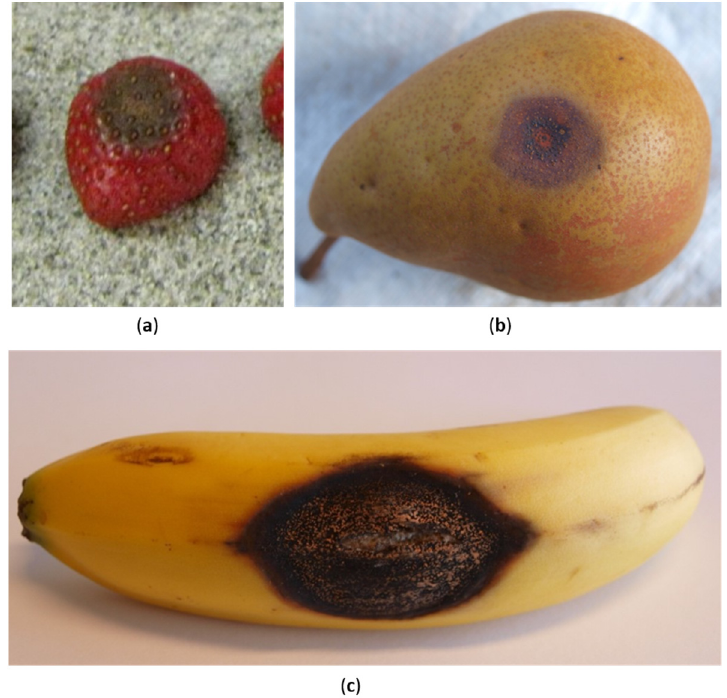
Figure 1. Anthracnose symptoms on harvested fruits. ( a ) Sunken brown lesions on strawberry fruits; ( b ) dark lesions surrounding orange conidia masses on pear fruits; ( c ) dark lesions on banana fruits.